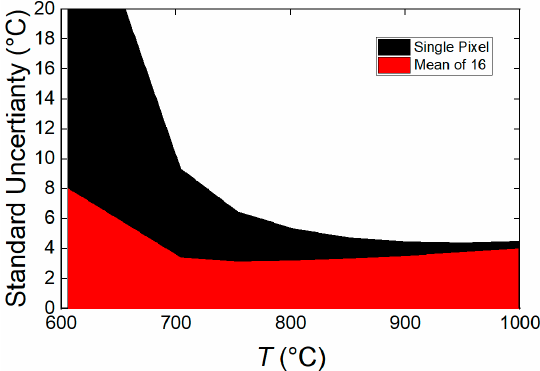
Figure 8. The combined Standard Uncertainty ( k = 1) of the Thermal PiCam when used as a thermal camera in the 600–1000 °C range. The averaging of pixels significantly reduces measurement uncertainty at the lower temperatures.